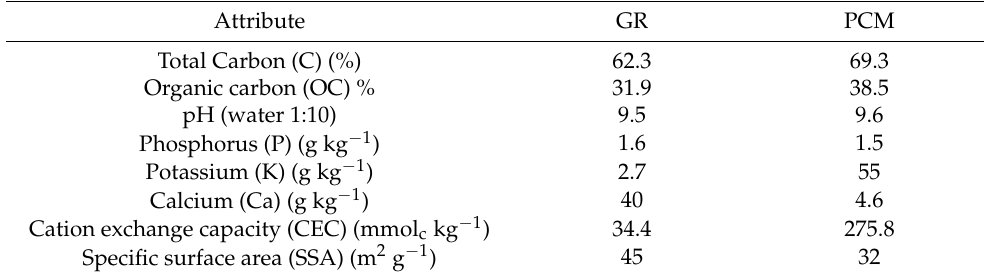
Table 1. Main attributes of the coffee grounds and coffee parchment biochars.